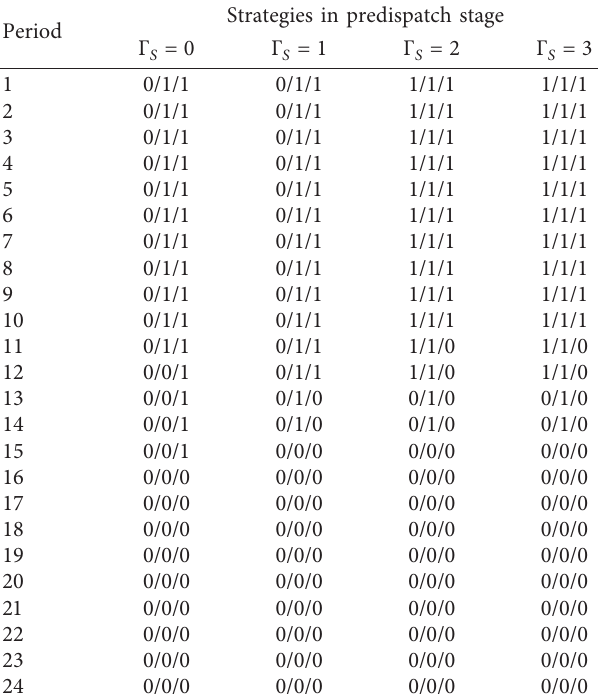
Figure 2: Predicted wind, solar, and load Table 6: Prescheduling strategies for the status of DGs at various Γ values ( Γ T � 24 ) .